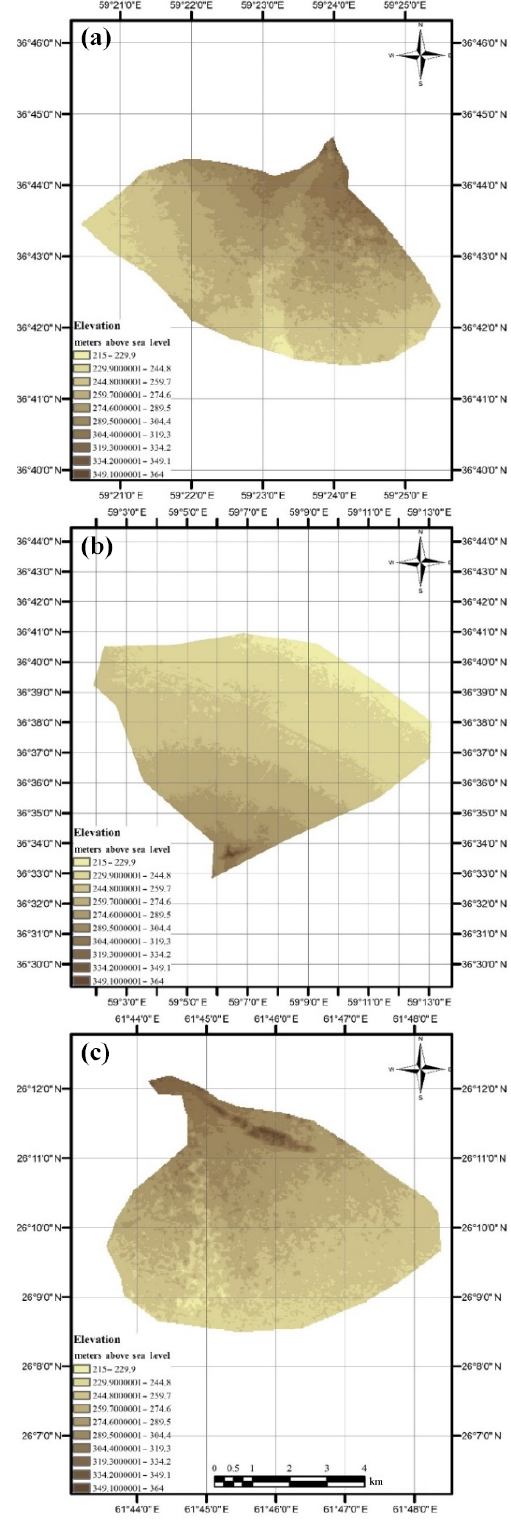
Figure 3. Land elevation from Aster dataset for the (a) Ardak, (b) Ferizy, and (c) Sarbaz